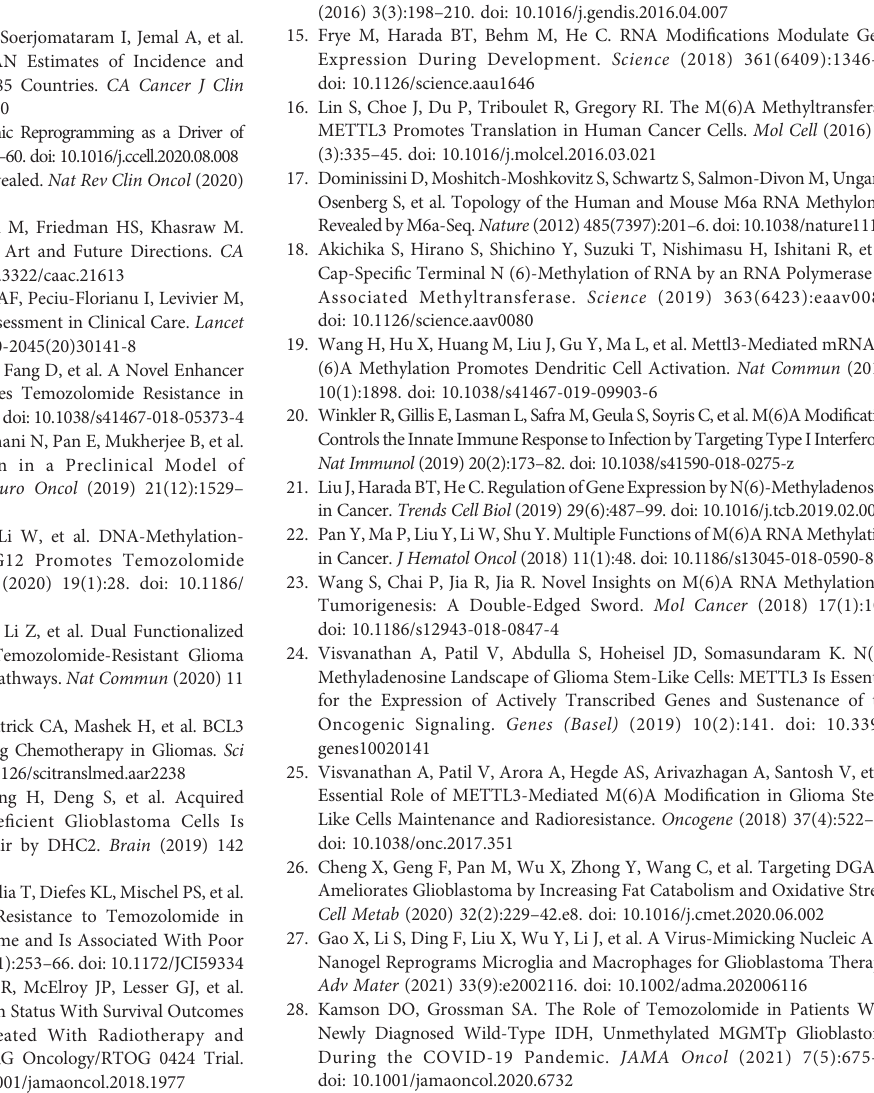
Supplementary Figure 1 | Generation of TMZ-resistant U87-MG and U251 cell lines. TMZ-resistant cell lines were generated by exposure of U87-MG and U251 cells to 200 m M of TMZ for over 6 months. The derived resistant cell lines were designated as U87-MG-TMZ resistant and U251-TMZ resistant, respectively. The cellsurvivalratio andhalfmaximal inhibitory concentration(IC 50 ) ofTMZ forU87-MG and U251 was evaluated by CCK-8 assay. Supplementary Figure 2 | METTL3overexpressionorknockdowndidnotaffectthe levelofMETTL14intheTMZ-resistanceGBMcells. (A)